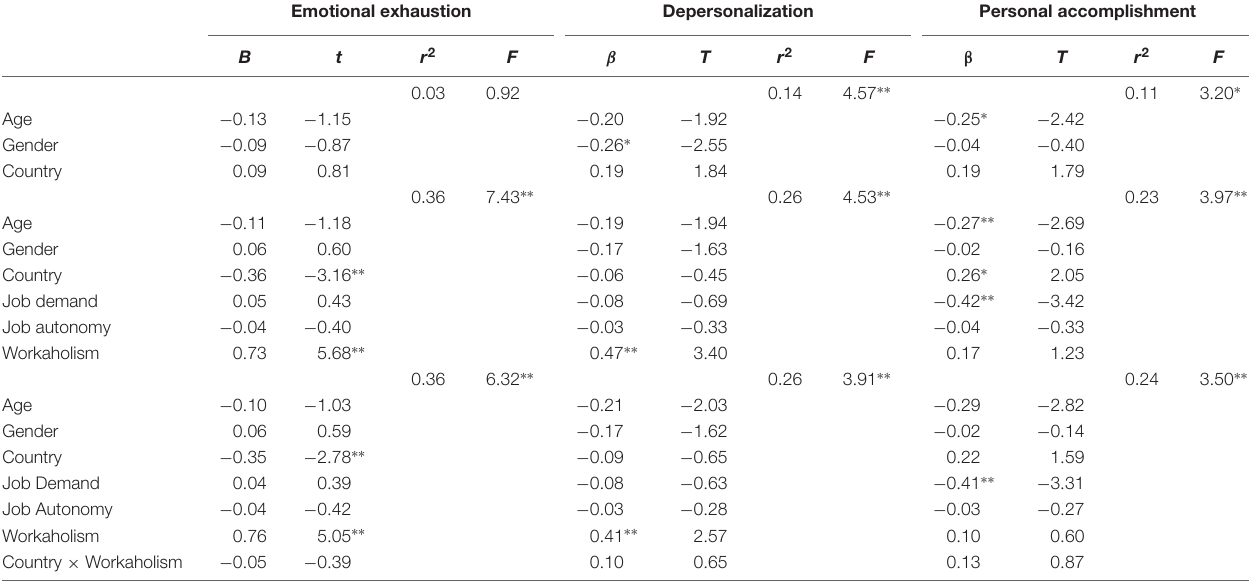
TABLE 6 | Moderated regression analysis for natural resources, mining, and construction